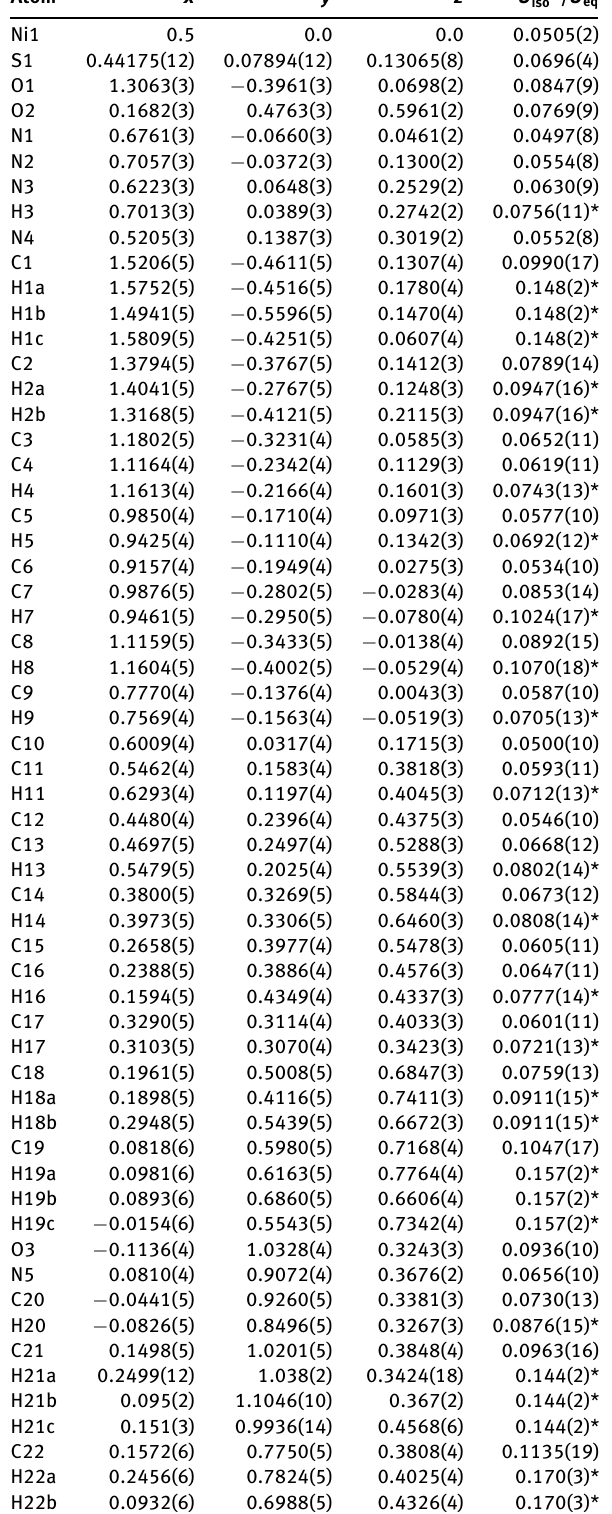
Table 2: Fractional atomic coordinates and isotropic or equivalent isotropic displacement parameters (Å 2